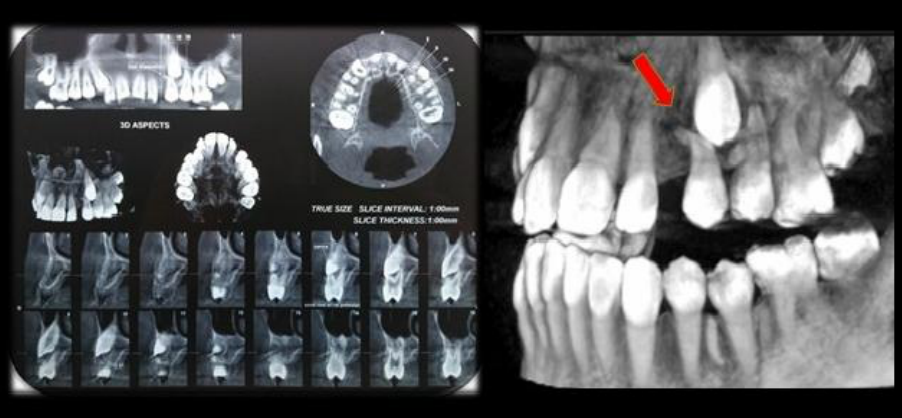
Figure 6. The CBCT views of the patient after five years follow-up at the age of 12.